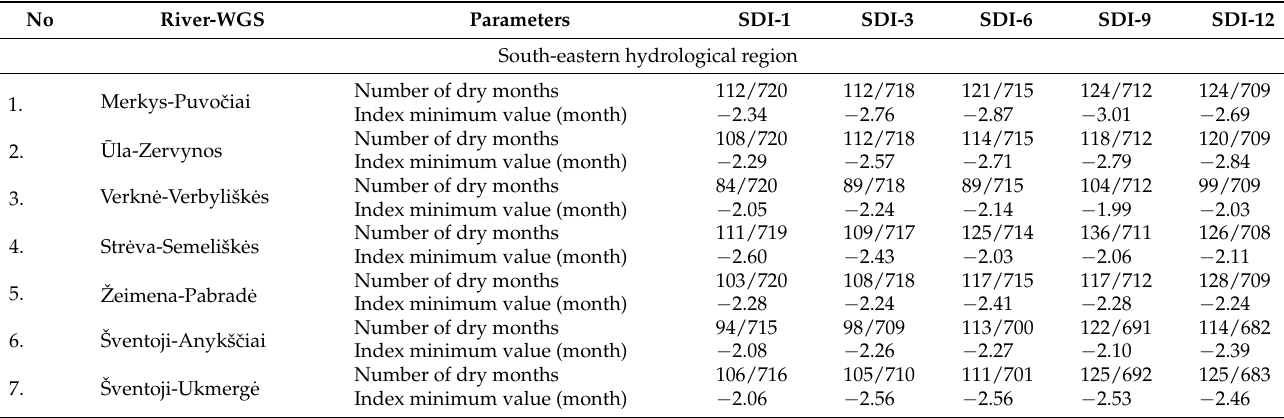
Table A3. SDI parameters which present the lowest value for each